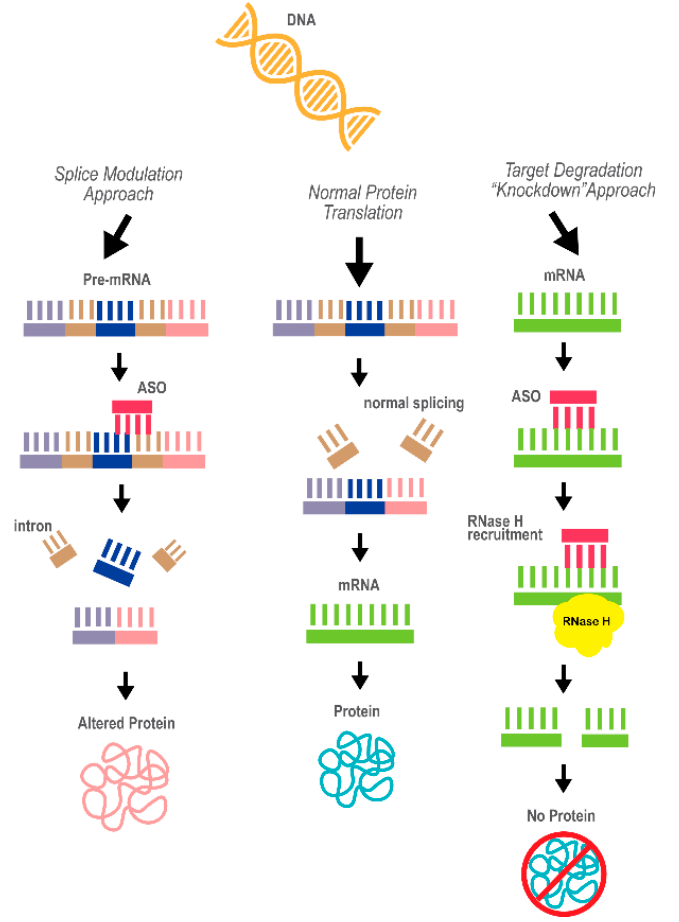
Figure 3. A diagram of the concept behind antisense oligonucleotide (ASO) technology as a thera- peutic approach. The two mechanisms underlying the ASO effects, splice modulation and target degradation (“knockdown”), are depicted. The ASO is marked in red. Purple, dark blue and pink represent different exons of the pre-mRNA; brown represents introns; green represent the processed mRNA (the product of correct splicing)